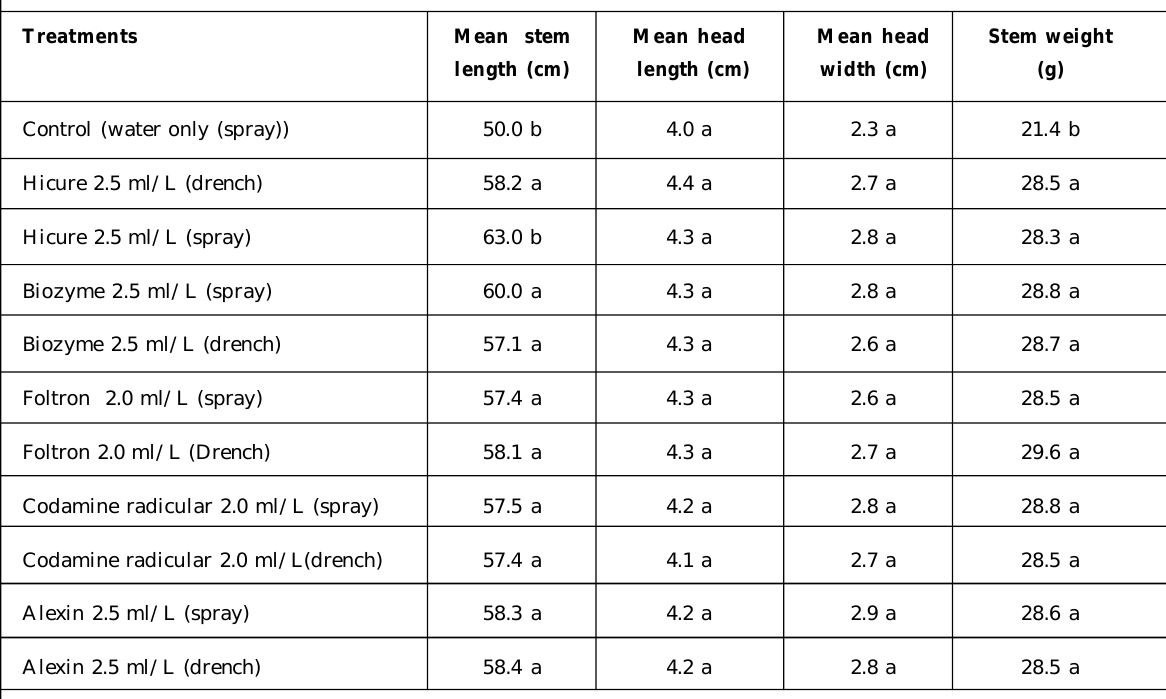
Table 4: Mean stem length, head length, head width and stem weight on plots treated with hicure 2.5 ml/L, control plots sprayed with water only (pooled data for one year)